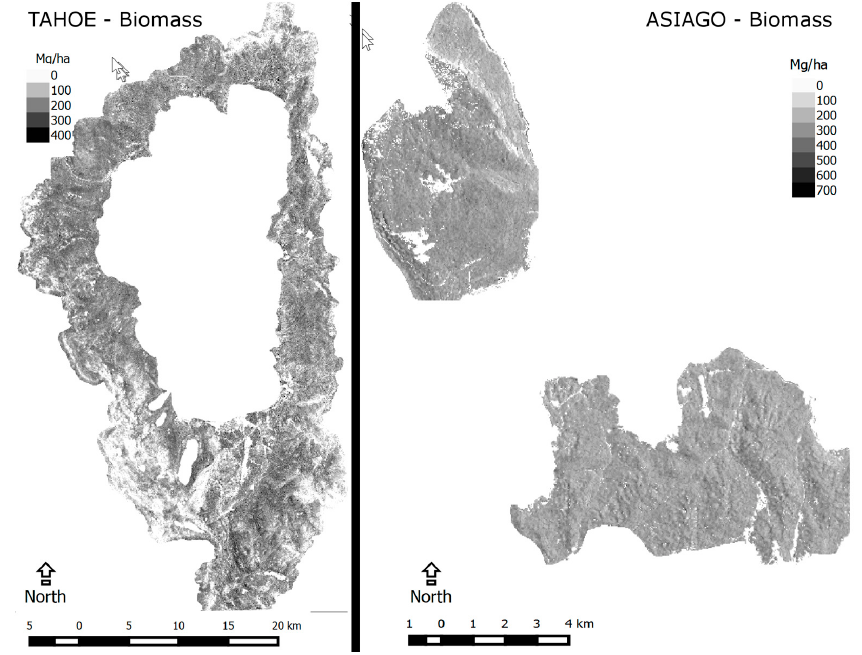
Figure 5. SAR + NDVI based map for Tahoe area ( left ) and Asiago area ( right ).